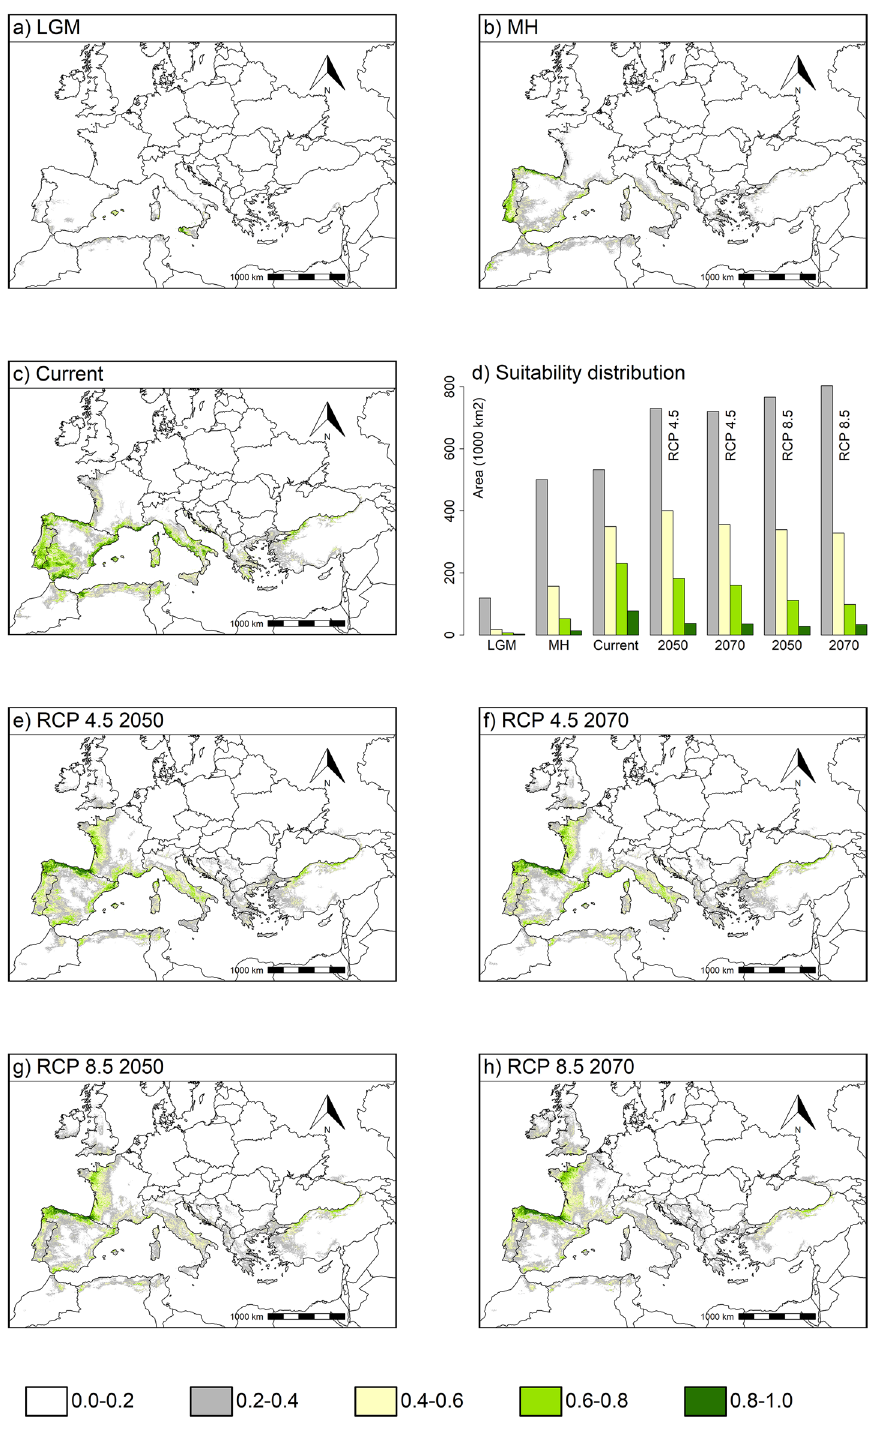
Figure 2. Arbutus unedo suitability areas. ( a ) LGM. ( b ) MH. ( c ) Current. ( d ) Evolution of the suitability areas from the LGM to the RCP 8.5 2070. ( e ) RCP 4.5 2050. ( f ) RCP 4.5 2070. ( g ) RCP 8.5 2050. ( h ) RCP 8.5 2070. Suitability class range: 0.0–0.2, non-suitable area; 0.2–0.4, low-suitability area; 0.4–0.6, general-suitability area; 0.6–0.8, medium-suitability area and 0.8–1.0, high-suitability area. Equal-area projection EPSG:3035. The map was made using the sf 1.0–3 and the terra 1.4–14 (https:// rspat ial. org/ terra/) packages in R 4.1.0 32,33